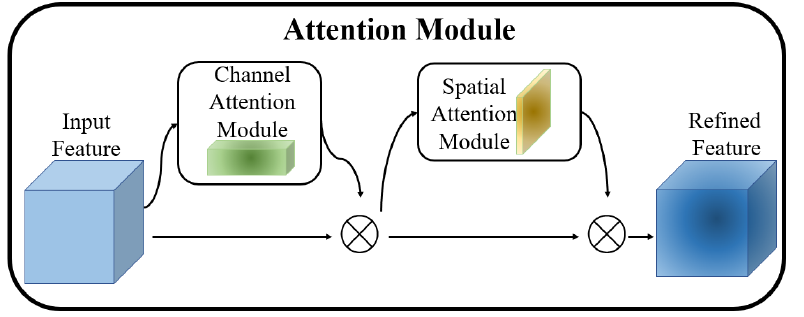
Figure 5. The overview of attention module.